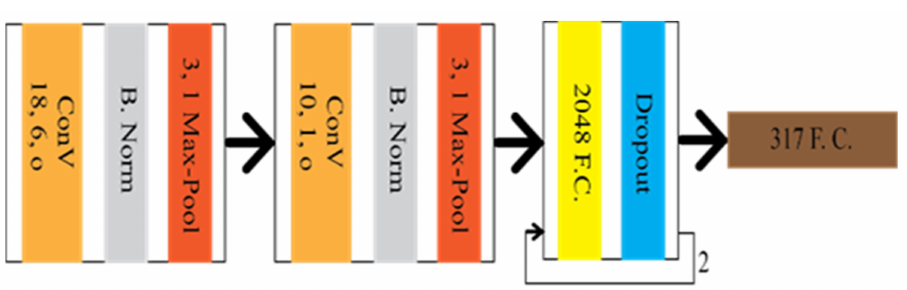
Figure 5. Schematic diagram of